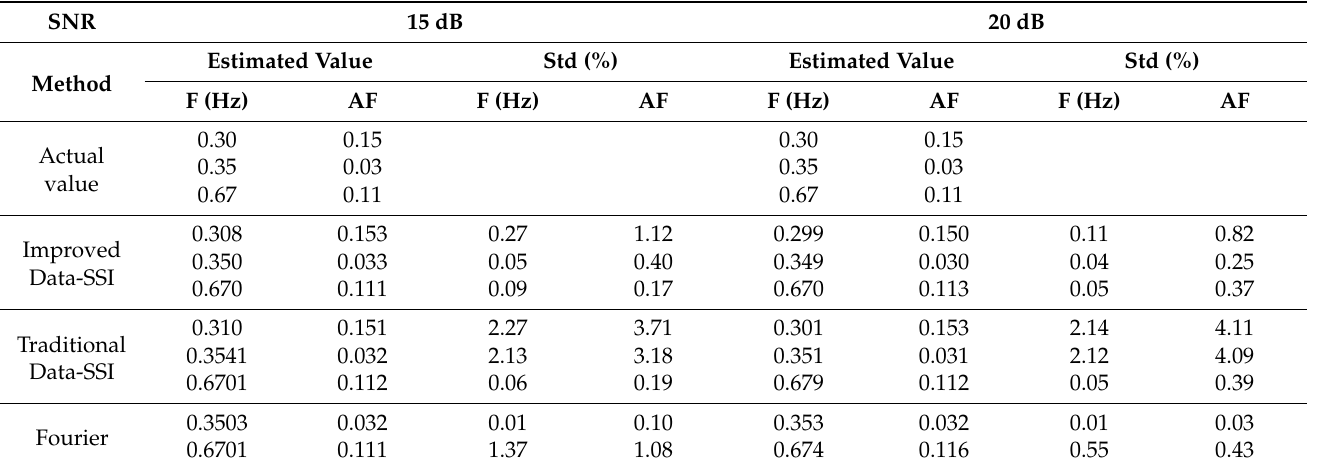
Table 2. Sensitivity analysis among the improved Data-SSI method, traditional Data-SSI method, and Fourier method.